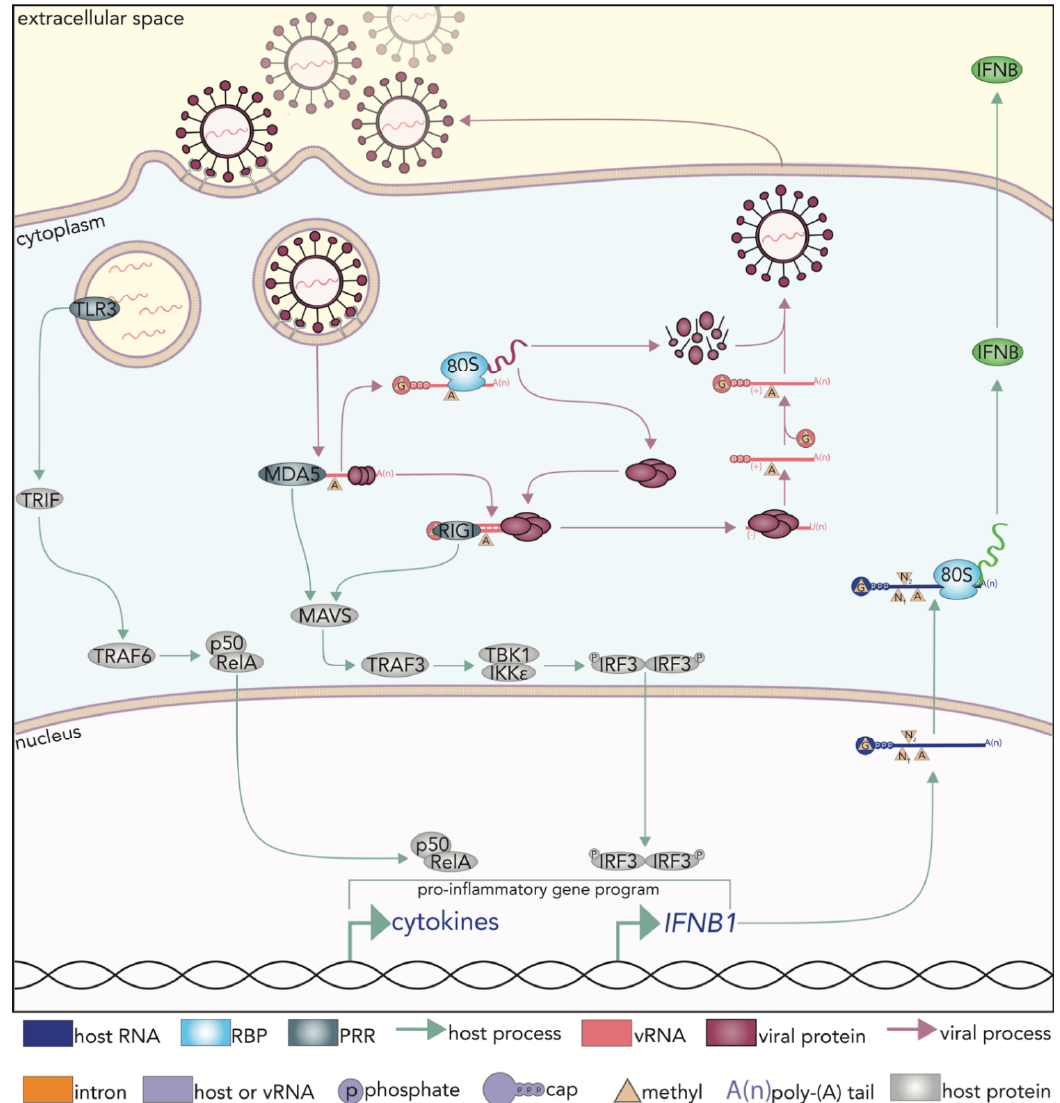
Figure 1 . PRR detection of viral RNA initiates a signaling cascade that causes widespread transcriptomic changes to cells. RNA-specific pattern recognition receptors (PRRs), some of which are pictured here, are responsible for detecting viral RNA. PRRs elicit a signaling cascade that typically results in a type I interferon response with the release of interferon beta (IFNB) into the extracellular space. Modelled is the Chikungunya virus replication cycle [10]. Toll like receptor-3 (TLR3) detects endosomal RNA Melanoma differentiation-associated protein (MDA5) and Retinoic acid inducible gene (RIG-I) detect cytoplasmic RNA. Activation of TLR3 results in Toll/Interluekin-1 receptor domain containing adapter-inducing IFNB (TRIF)-mediated induction of the IFNB and NF- κ B (p50/RelA) pathways. Activation of the RLRs induces an Interferon regulatory factor 3 (IRF3)-mediated signal transduction response that results in the expression of IFNB1 . Innate immune activation of cells via NF- κ B, IRF activities, or a type I interferon stimulation lead to profound transcriptomic changes for which existing and newly expressed RBPs must engage in order to properly orchestrate an effective pro-inflammatory and anti-viral